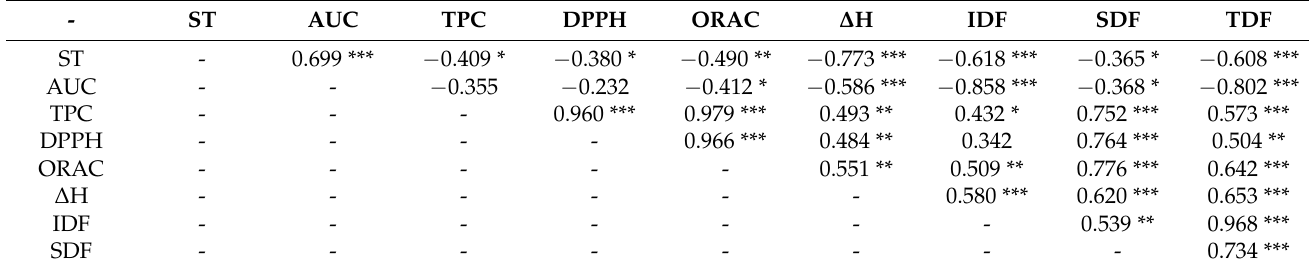
Table 2. Pearson’s correlation coefficient ( r ) of physicochemical and nutritional properties of bread